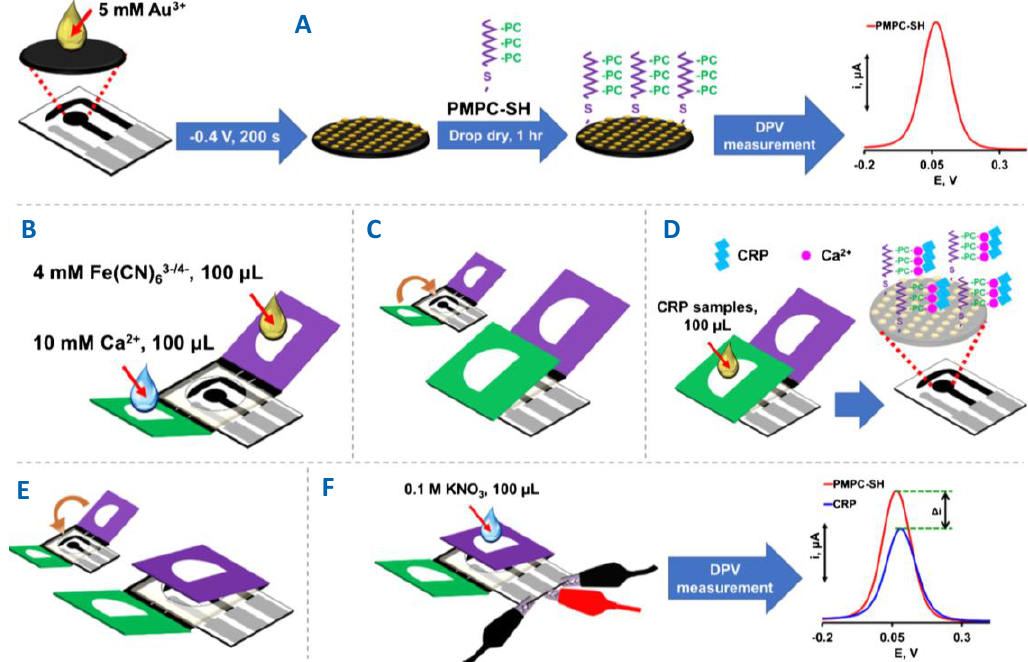
Figure 4. ( A ) Preparation of thiol-terminated poly(2-methacryloyloxyethyl phosphorylcholine) (PMPC-SH)-AuNPs/SPCE. ( B – F ) Steps for preparation of the PMPC-SH-AuNPs/SPCE/PAD sensor for the differential pulse voltammetry (DPV) determination of C-reactive protein (CRP). Reproduced and adapted with permission of Springer [31].